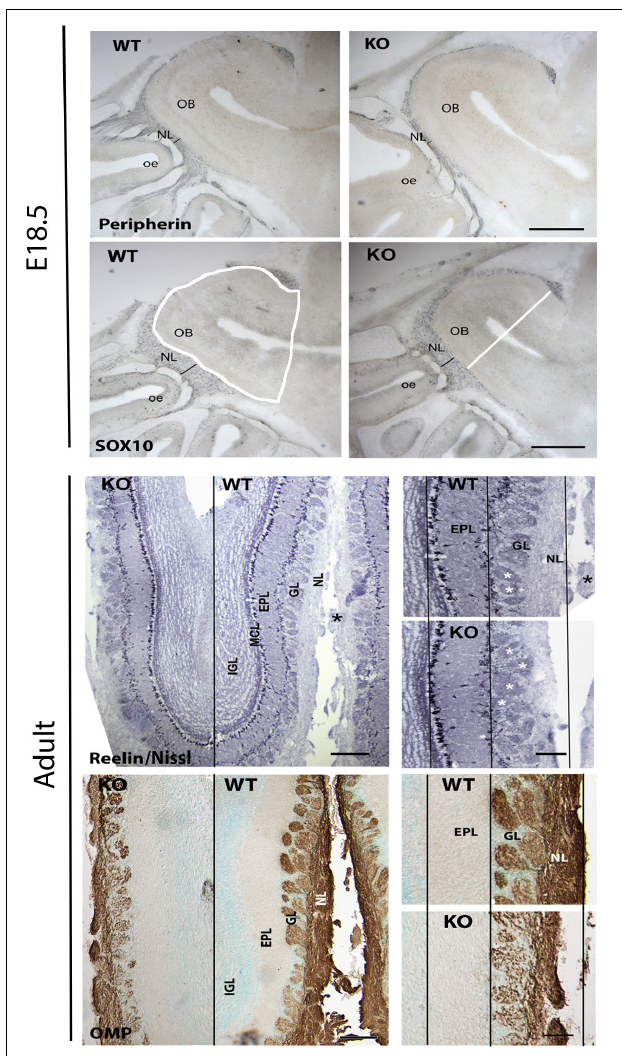
FIGURE 9 | Absence of GPR37 impacts olfactory nerve layer development. Upper panels show examples of immunocytochemical staining from E18.5 WT and KO embryos stained (blue) for peripherin and Sox10, markers for axons and OECs in the olfactory nerve layer. A significant decrease in the olfactory nerve layer (NL) thickness (black line) was found (Sox10 staining decreased 29% (WT = 133.5 ± 7.8 µ m, KO = 95.3 ± 6.4 µ m, N = 7/genotype, p = 0.003)] and (peripherin staining decreased 47% (WT = 100.2 ± 6.9 µ m, KO = 53.4 ± 3.1 µ m, N = 4/genotype, p = 0.0008)]. Lower panels show examples of adult olfactory bulbs from GPR37 WT and KO mice stained with Nissl to delineate the layers and OMP staining to mark the olfactory nerve layer. Left: low magnification of coronal sections. Black line separates KO from WT. Higher magnification of each shown on right (white asterisk = glomeruli). Black lines are drawn through the mitral cell layer (MCL), outer aspect of the external plexiform layer (EPL) and the outer aspect of the NL using the dimensions of the WT tissue. A reduction in the ONL was found in KO mice. GL, glomerular layer. Scale: top panel = 400 µ m, left bottom panel = 200 µ m, right bottom panel 100 µ